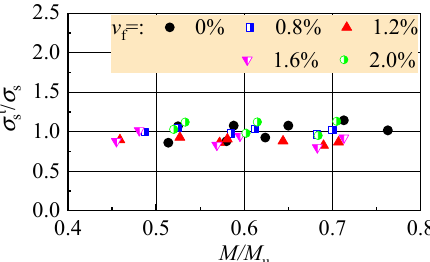
Figure 6. Ratio of tested to calculated values of the rebar stress at normal service.